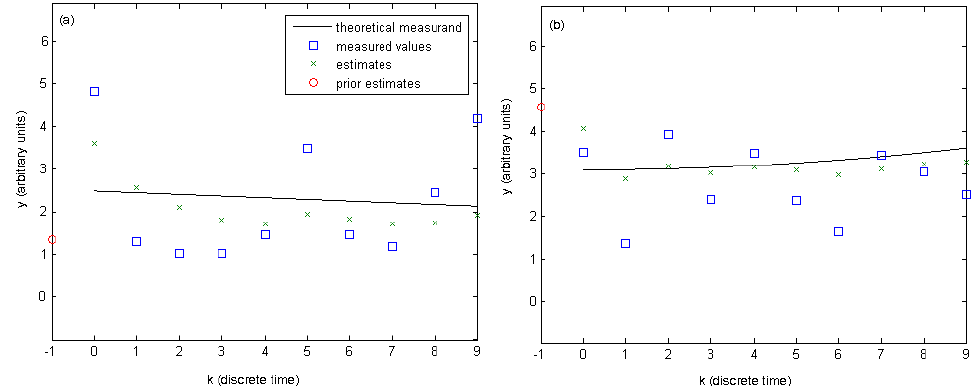
Fig. 4. Acyclic patterns for (a) S 1 and (b) S 2 : simulation results.